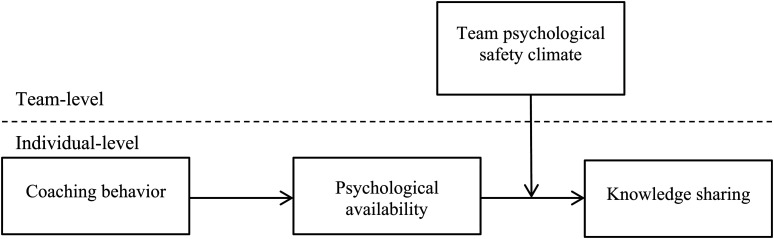
Theoretical model.